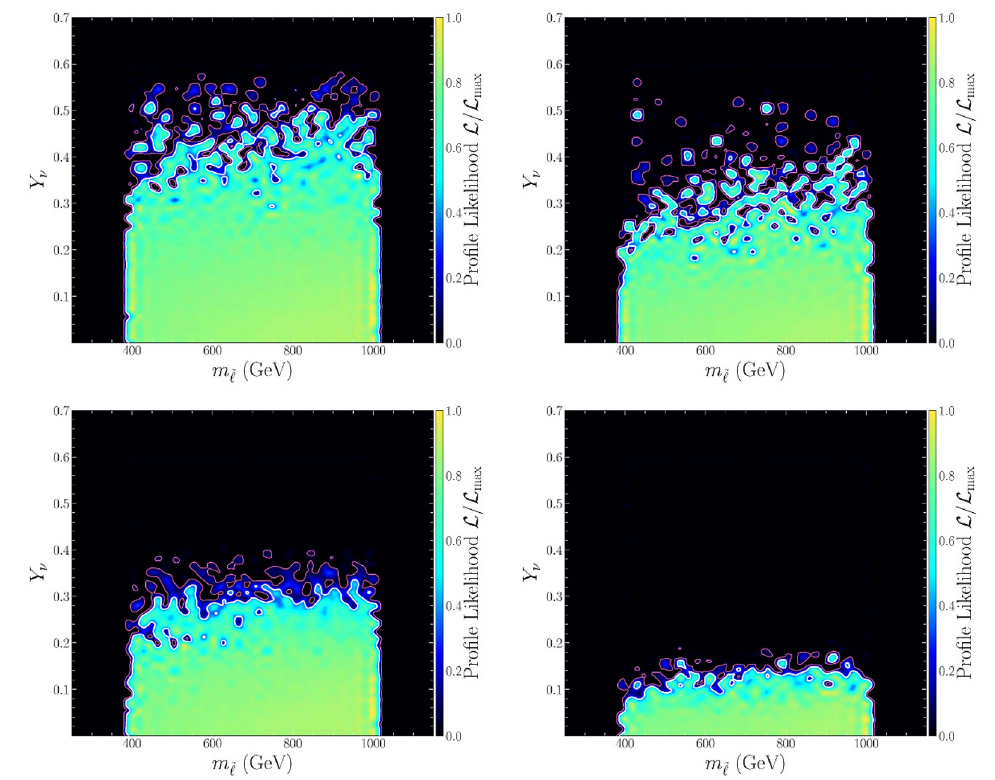
Figure 9 . Same as figure 4, but for the massive h s scenario defined in table